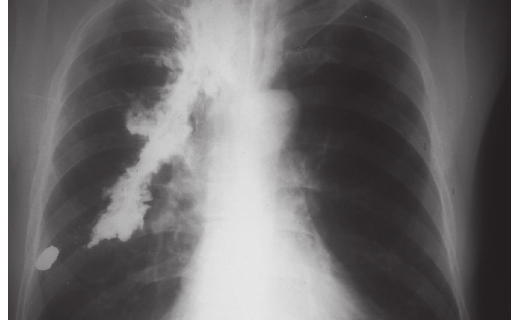
Figure 4 - Postoperative chest roentgenogram several weeks after the treatment of esophageal perforation due to a gunshot wound. No complications related to barium